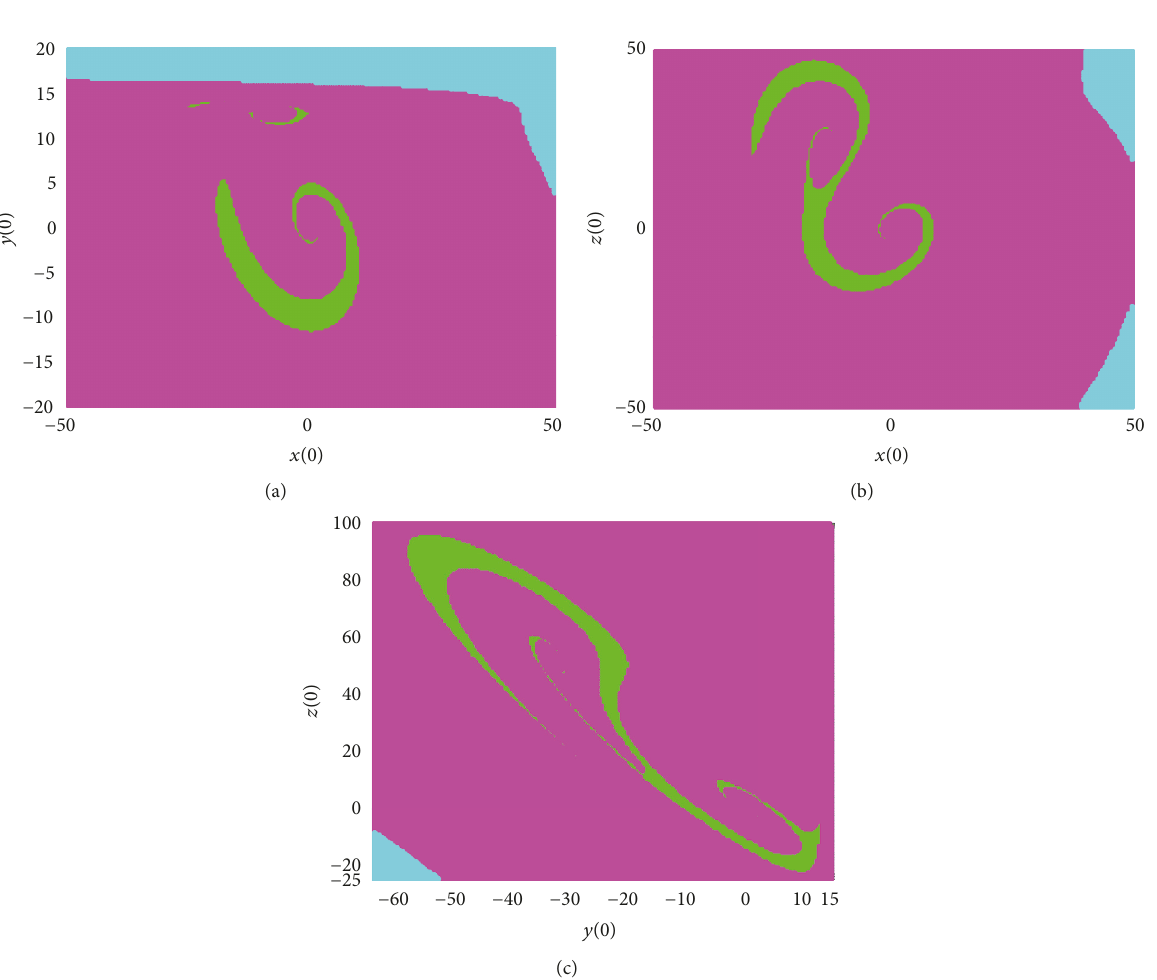
Figure 8: Structure of the three cross sections of the basin of attraction with 𝑧(0) = 0 and ( 𝑥(0) , 𝑦(0) ) in the ranges −60 ≤ 𝑥(0) ≤ 50 and −25 ≤ 𝑦(0) ≤ 100 obtained for 𝜇 = 1.100 . We present the basin of attraction for the chaotic coexistence (a): magenta regions correspond to asymmetric single-band chaotic attractor (screw-like Shilnikov), while green ones are related to another single-band chaotic attractor (spiralling-like Feigenbaum). Blue zones correspond to unbounded solutions. These regions represent initial conditions that lead to each chaotic